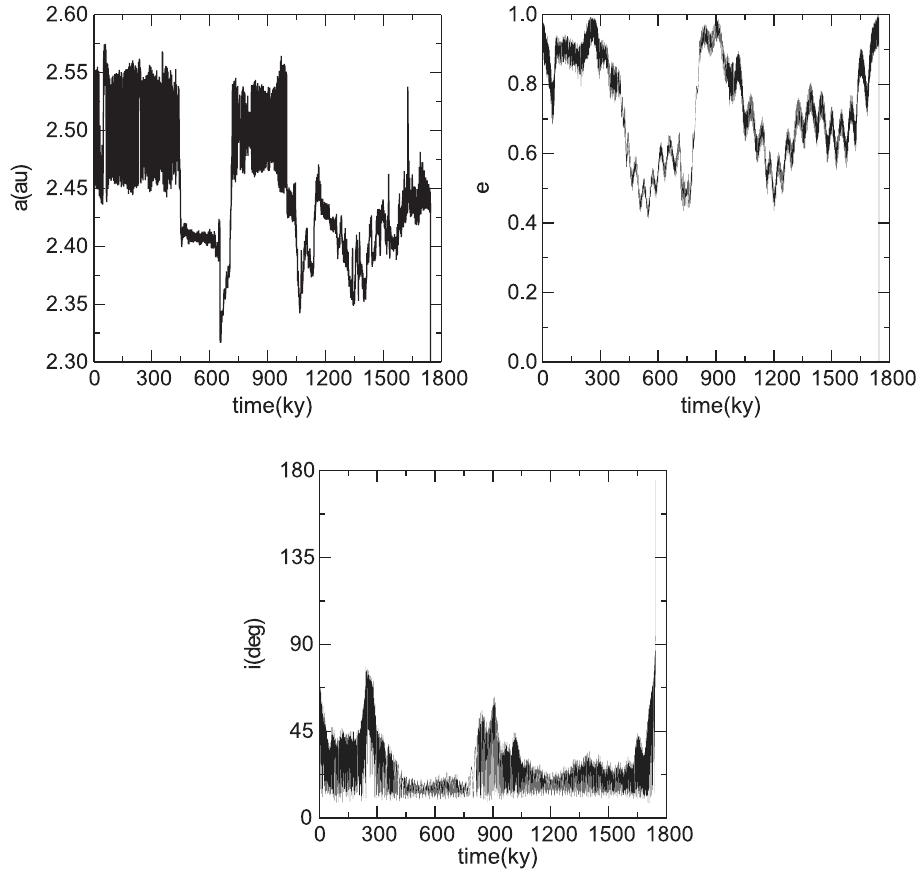
Figure 5: Forward orbital evolution of the comet 322P with the NG e ff